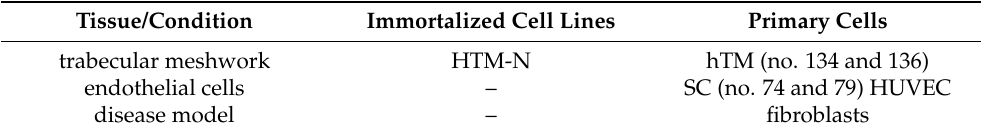
Table 2. Cell types used for the cellular uptake of NPs in